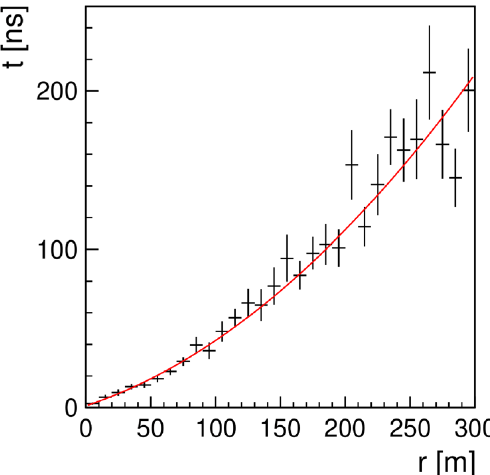
Fig. 6 Arrival time as a function of the distance to the core for an event with X max = 339gcm − 2 and E 0 = 1 . 3 TeV. The line correspond to a quadratic fit as explained in the text with its χ 2 / ndf = 0 . 93 (see text for the simulation details)